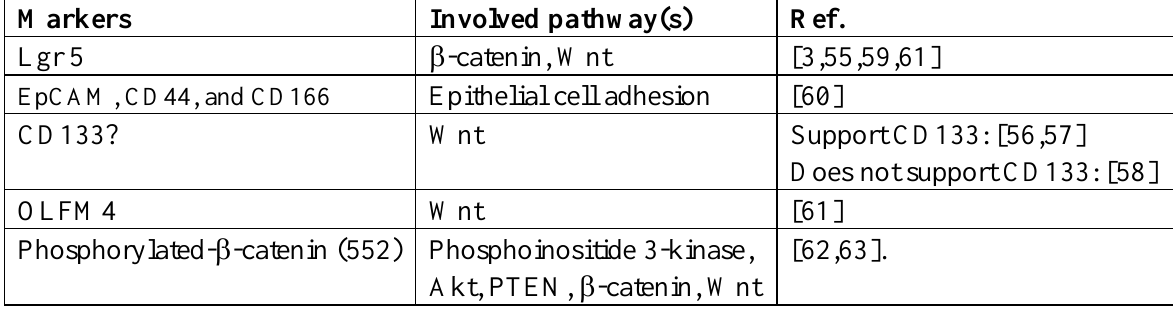
Table 1. A summary for colon cancer stem cell